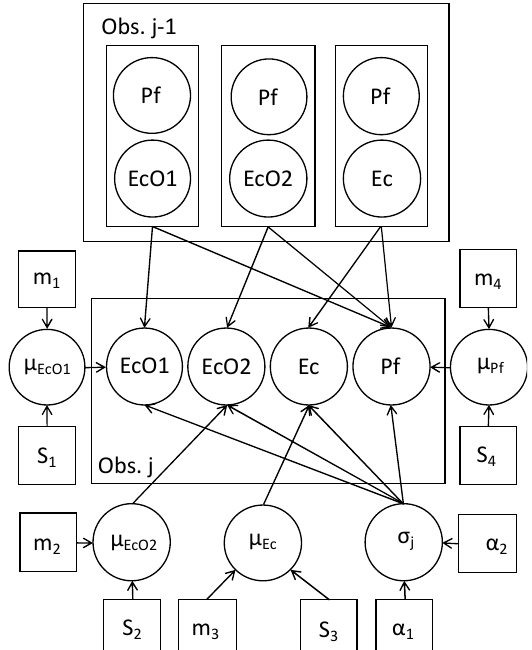
Figure 1. Bayesian model directed acyclic graph (DAG). Circles: random variables. Squares: constants (initial parameters of the distributions of the variables). Arrows: conditional dependence. Obs. j-1: observed data of E. coli spp. (EcO1, EcO2, and Ec), and P. fluorescens (Pf). µ : microorganisms’ growth rates with Normal distribution (mean m and standard deviation S). σ j : standard deviation of errors with a Gamma distribution (parameters α ).